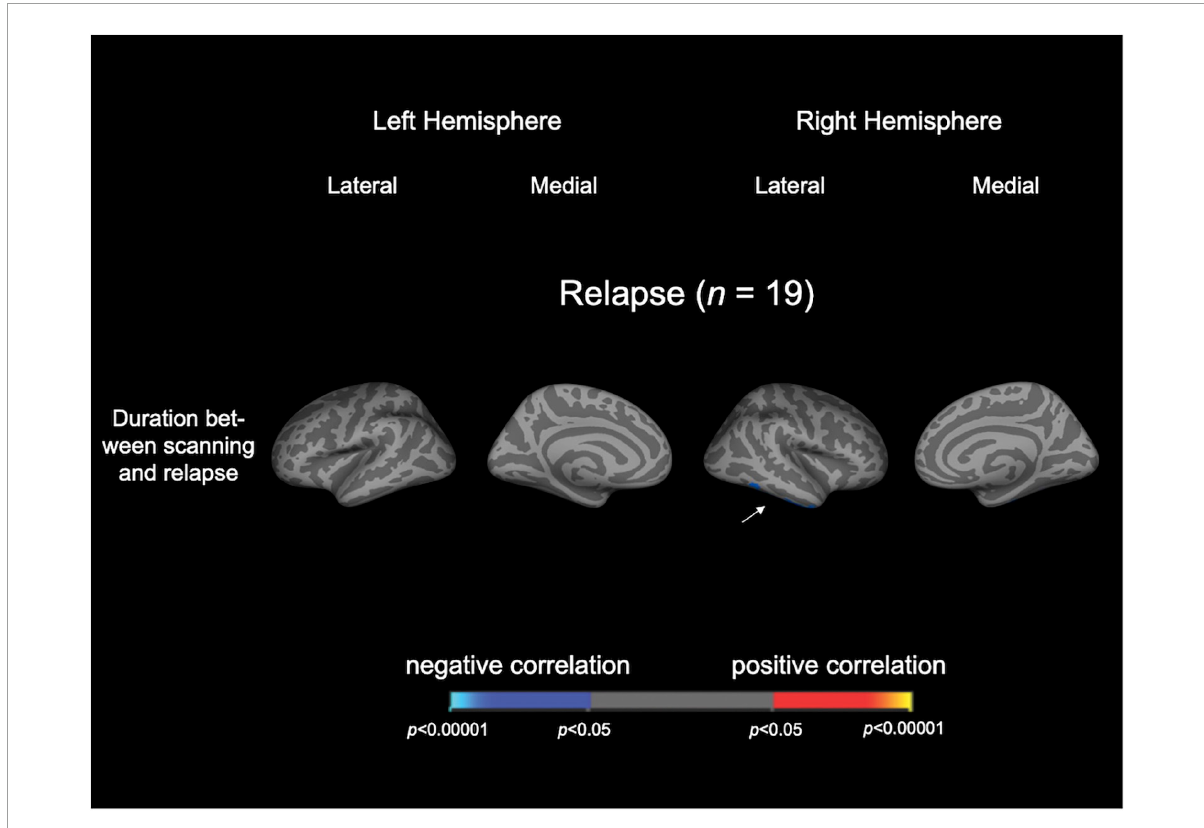
FIGURE2 Cortical statistical maps displaying the significant correlation of local gyrification index with clinical variables in patients with schizophrenia. The maps are shown for the right and left hemispheres in lateral and medial views. An arrowhead in the figure indicates the location of clusters associated with time to relapse. Horizontal bar shows p -values ( p < 0.05, corrected).